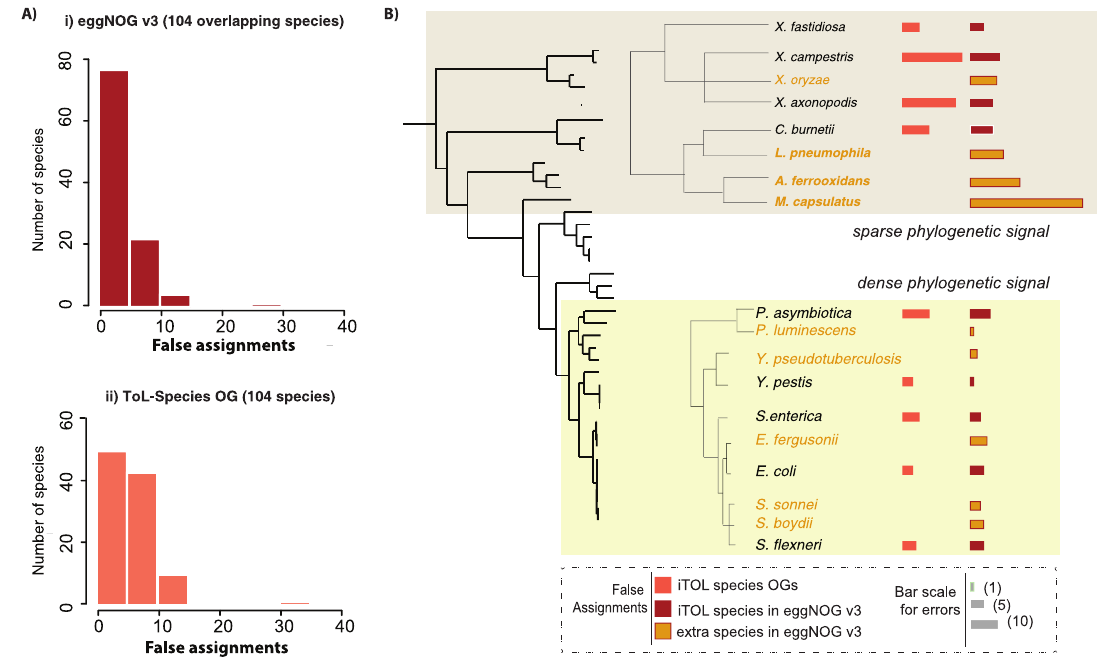
Figure 4. Species selection is the most influential factor for robust orthology inference. The in-house pipeline eggNOG was used to generate orthologous groups based on 104 gamma-Proteobacteria species that belong to the Tree of Life (ToL) –so called ToL-Species OGs. A) For each of the 104 species, we count the number of false assignments in the ToL-Species OGs and eggNOG database (v3). The distribution of errors between the two datasets is significantly different (p-value ,, 0.05, Kolmogorov–Smirnov test). B) Bar plots illustrate the species-specific contribution in the false assignments pool. Species with ‘‘dense’’ (taxonomical clades with a large number of closely related bacteria) and ‘‘sparse’’ (taxonomical clades with small representation) phylogenetic information show a different accumulation pattern (false assignments across all 49 RefOGs). Species in black letters exist both in ToL-Species OGs and public eggNOG (overlapping species), while species in orange letters indicate eggNOG-specific species (not present in the Tree of